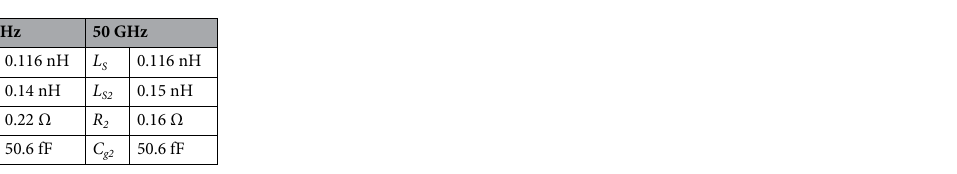
Figure 4. ( a ) Fabricated tunable two-frequency spoof SPP device and equivalent circuit models for the two spoof SPP units. ( b ) IGZO resistance within the SRR gap as a function of voltage at 34.7 GHz and 50 GHz, respectively. The inset shows the resistance–voltage curves of the Schottky diodes with various IGZO thickness. ( c ) System set-up with Agilent PNA N5247 and SMU B2902A. The inset shows the device under test. ( d ) Measured S-parameters of the fabricated device.